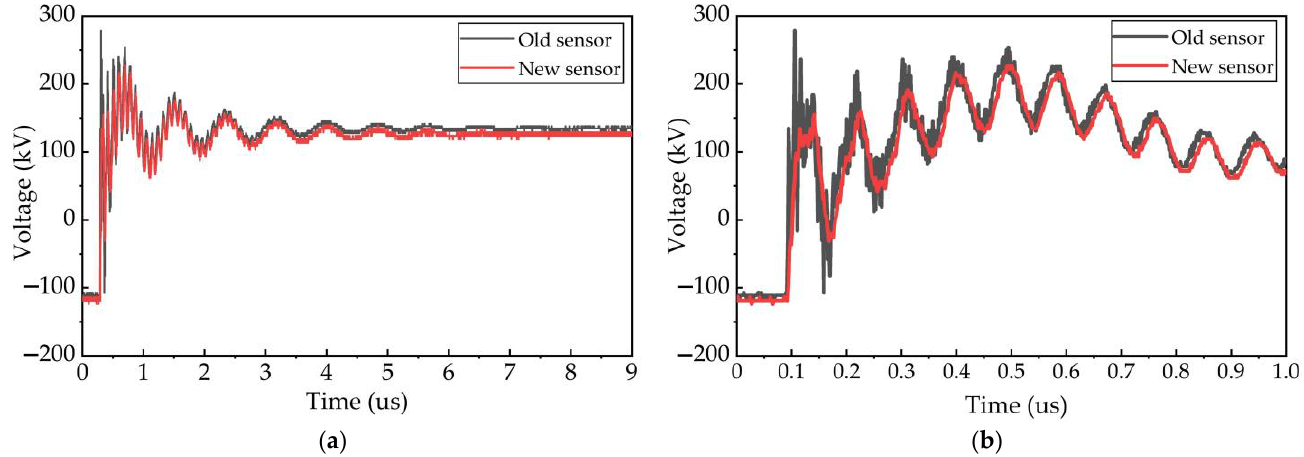
Figure 16. The typical micro pulse waveform of VFTO. ( a ) The whole process waveform of micro pulse; ( b ) the micro pulse waveform within one microsecond.